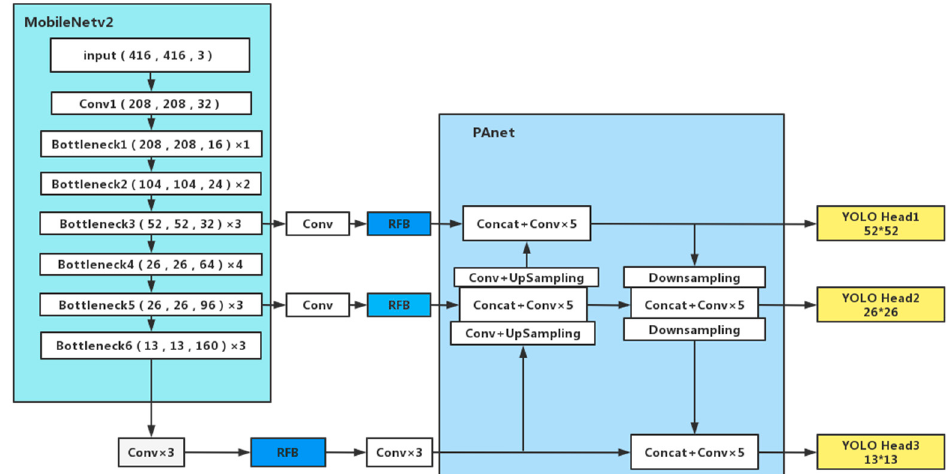
Figure 4. YOLOv4-LITE-MR network structure. The blue part is the added position of the improved RFB structure.